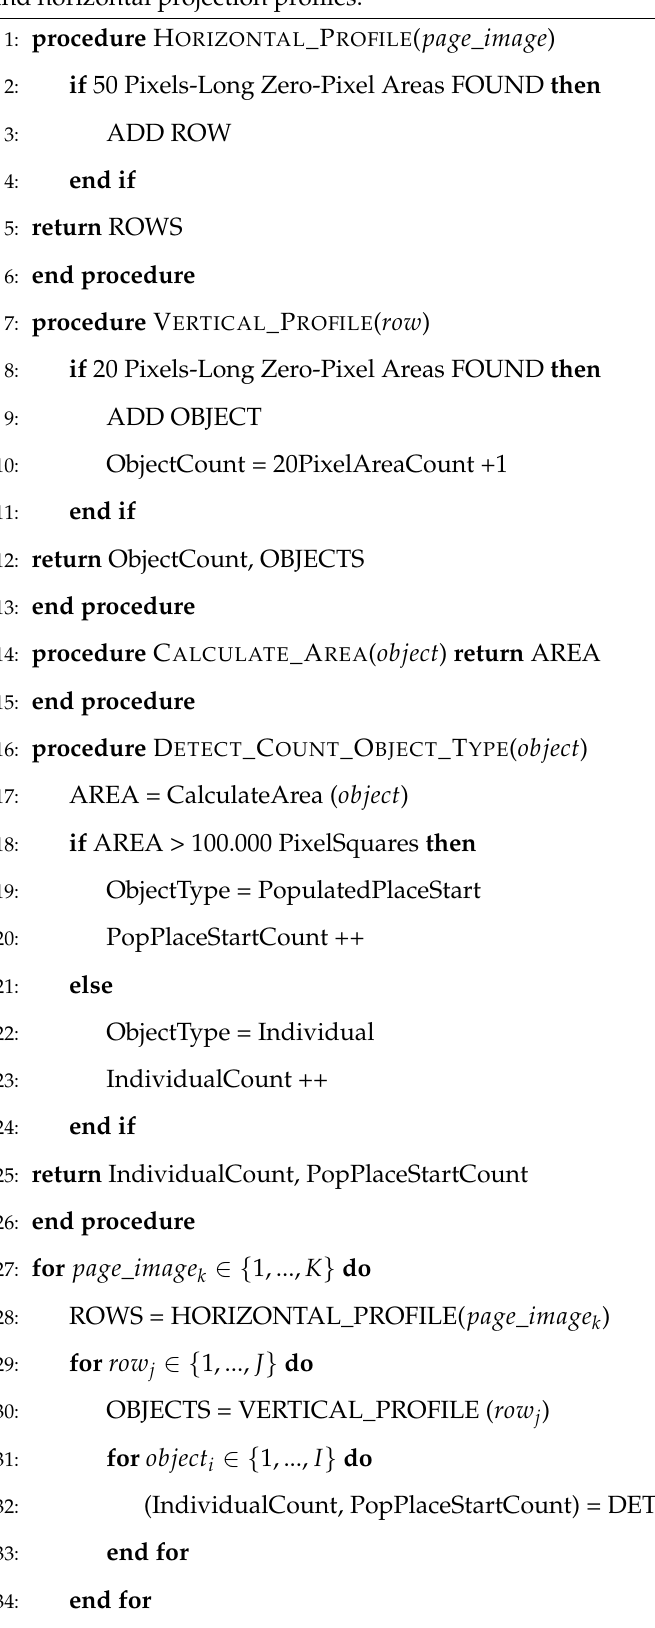
Algorithm 2 Detecting and counting objects belonging to different classes with the heuristic vertical and horizontal projection